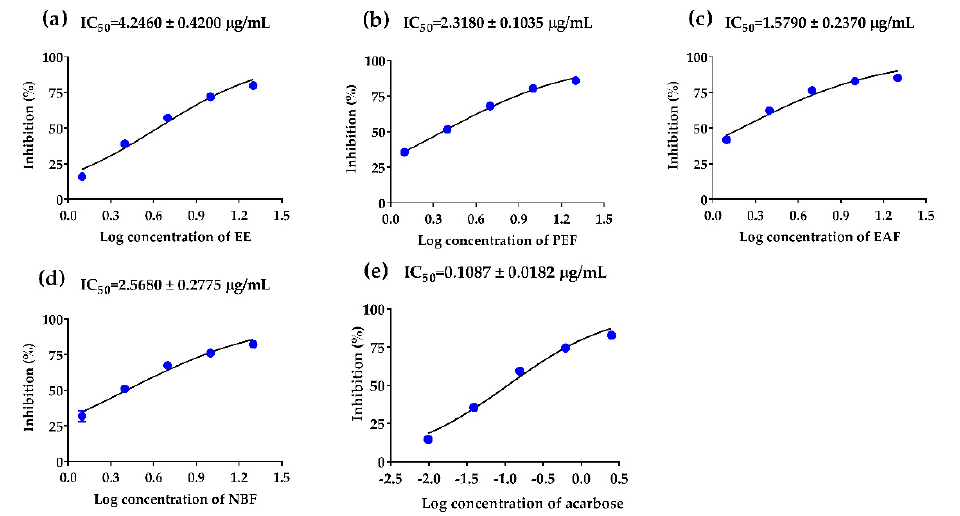
Figure 1. α -Glucosidase inhibitory effects of PAHEE and its fractions. ( a ) Log concentration–inhibition rate fitting curve of PAHEE. ( b ) Log concentration–inhibition rate fitting curve of petroleum ether fraction (PEF). ( c ) Log concentration–inhibition rate fitting curve of ethyl acetate fraction (EAF). ( d ) Log concentration–inhibition rate fitting curve of n-butanol fraction (NBF). ( e ) Log concentration–inhibition rate fitting curve of acarbose. Calculated the IC 50 value of different groups by Statistical Product and Service Solutions (SPSS, version: 21.0, International Business Machines Corporation, New York, USA), and all values are mean ± SD from a least three independent experiments.